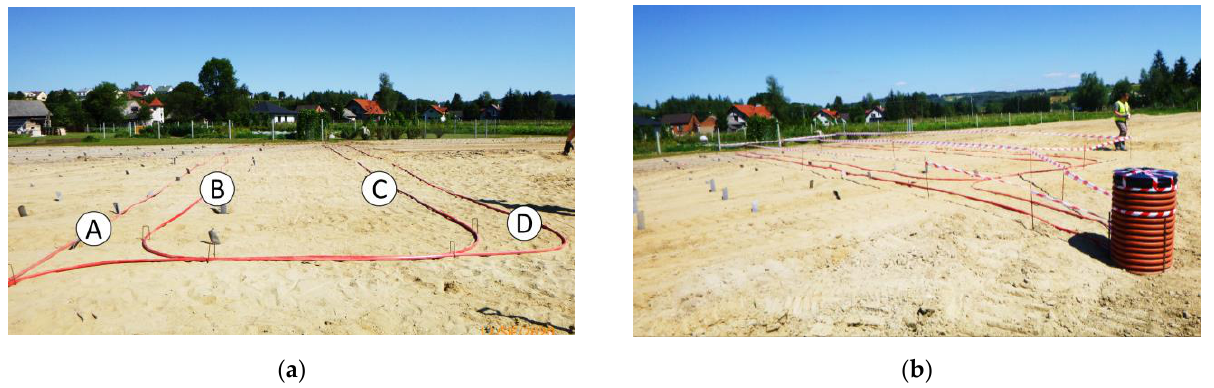
Figure 16. ( a ) Hydraulic sensor delivered to construction site in coil; ( b ) installation by stabilizing the sensor in the de- signed positions by means of the mounting brackets.